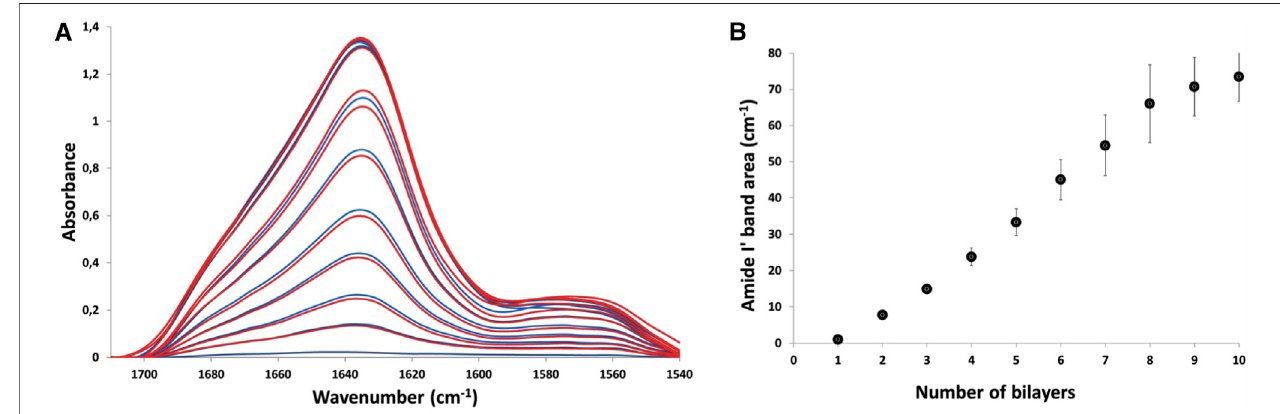
FIGURE 1 | Layer-by-layer fi lm assembly followed by ATR-FTIR: (A) ATR-FTIR spectra acquired during the buildup of a (PLL 30 -Fn) 10 LbL thin fi lm, after each adsorption of PLL 30 (blue) and after each adsorption of Fn (red). The fi lm was constructed on a silicon crystal. The amide I ′ band (1,600 – 1,700 cm − 1 ) and amide II ′ band (1,540 – 1,600 cm − 1 ) are represented. (B) Evolution of the Amide I ′ band area measured by ATR-FTIR during multilayer fi lm formation. The amide I ′ band area measured after each PLL 30 adsorption is shown. The vertical lines represent the estimated error on each point.